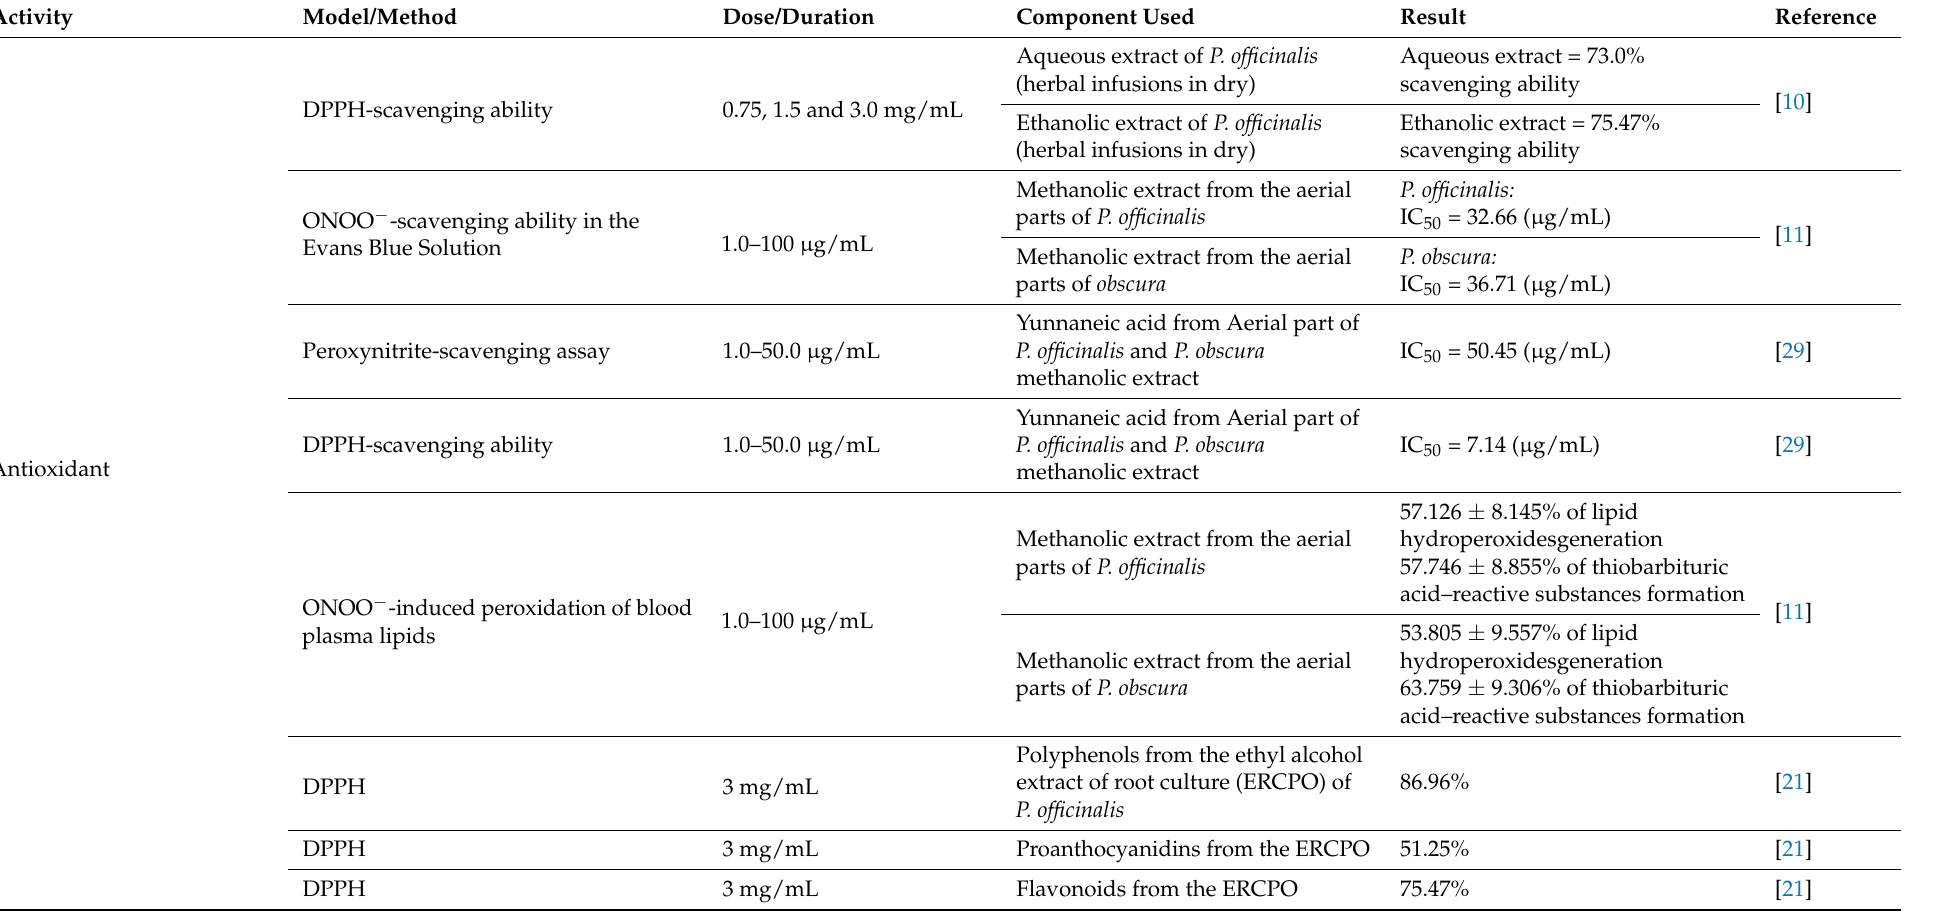
Table 1. Different biological activity observed of lungworts observed in in vitro/in vivo